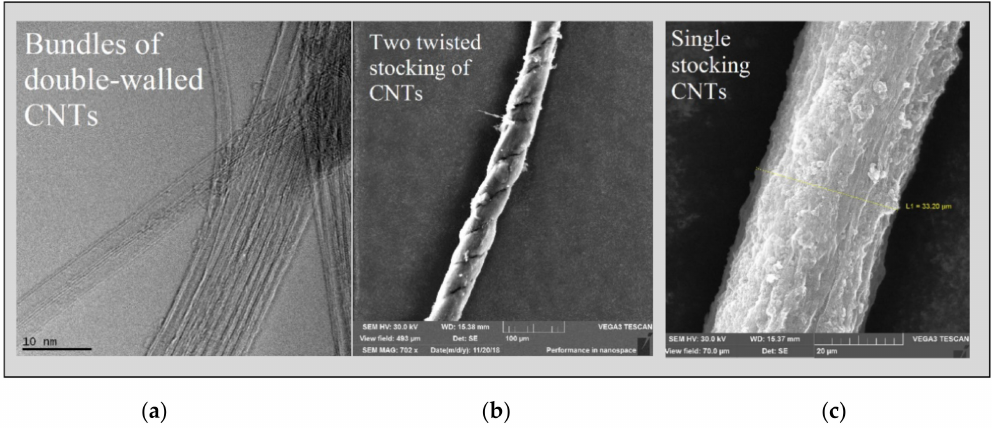
Figure 5. Electron microscopy images of the nanotubes produced with ferrocene as a catalyst precursor: ( a ) TEM of double-walled nanotube bundles; ( b ) Low resolution SEM of a thread twisted from two nanotube sprouts stocking; ( c ) a thread produced from a single nanotube